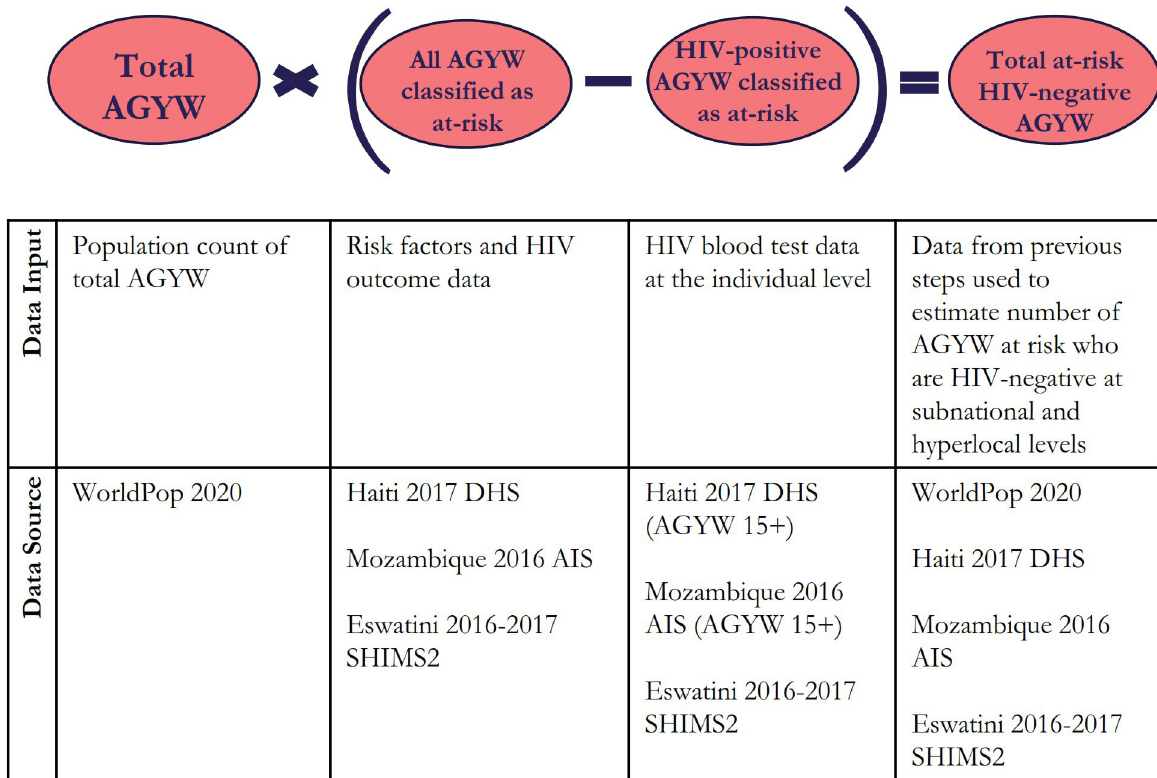
Fig 1. Population size estimation process: AGYW who are HIV-negative and at risk for HIV infection.